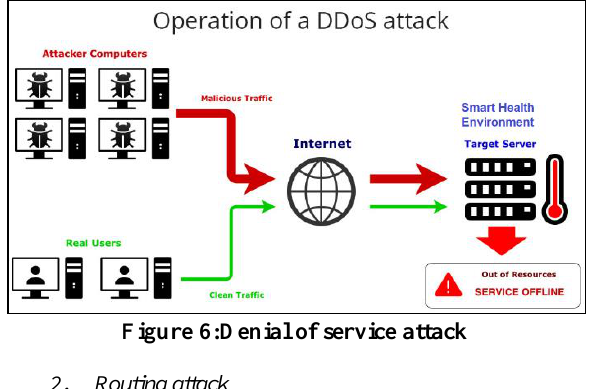
Figure 6:Denial of service attack